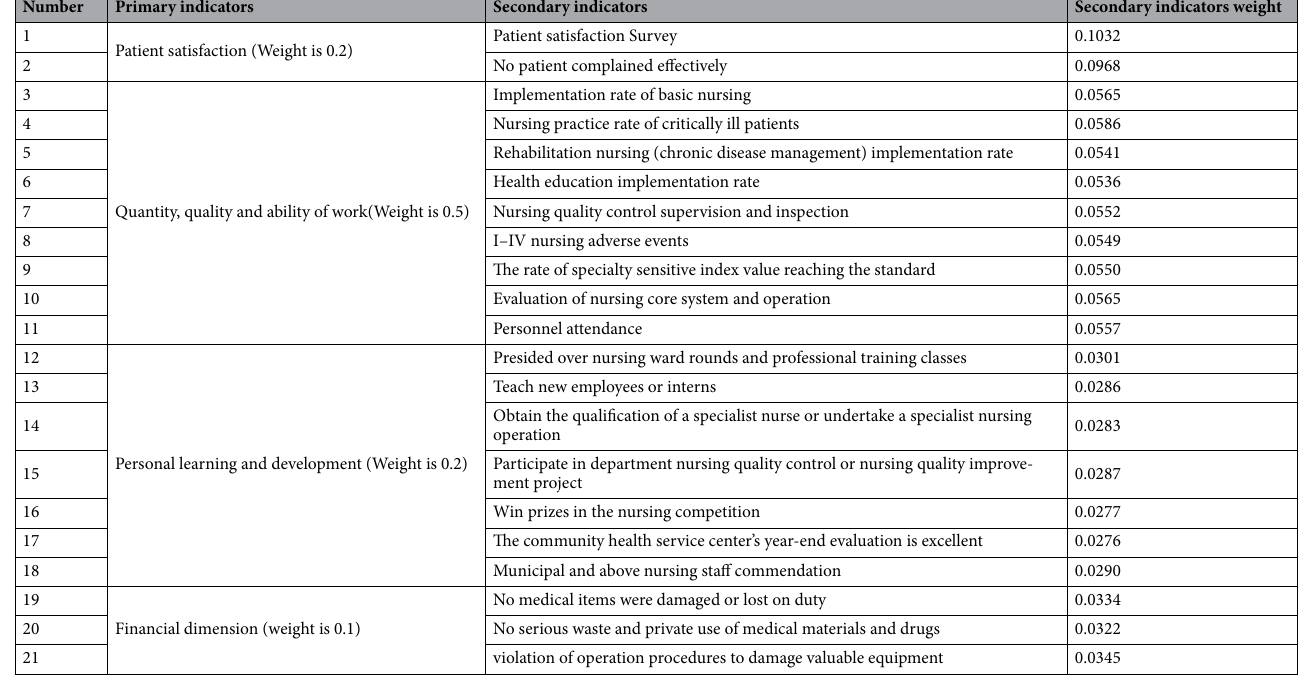
Table 4. Clinical nurse performance evaluation model.